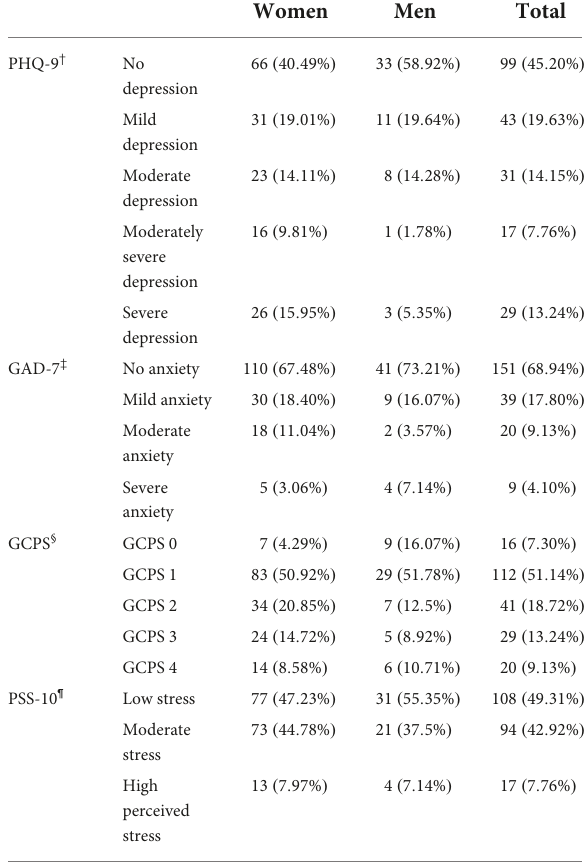
TABLE 4 Questionnaires scores for women and